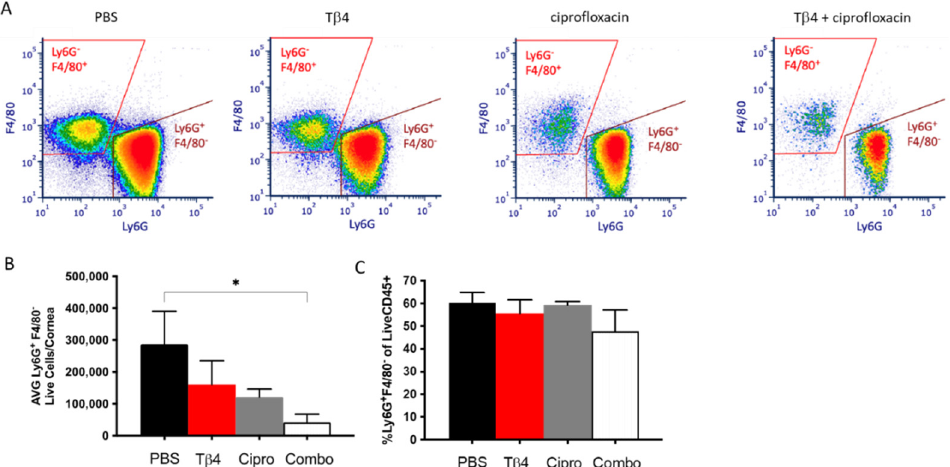
Figure 1. Flow cytometry results of PMN cellular infiltrates following P. aeruginosa -induced corneal infection. CD45 + Ly6G + F4/80 − leukocytes identified as PMNs as determined by flow cytometry at 3 days p.i. in corneas of PBS-, T β 4-, cipro-, and adjunct T β 4-treated B6 mice ( A ). Results are shown as averages of single cell populations ( B ) and % of live PMNs per total population of live leukocytes ( C ). n = 5 corneas/group; * p <